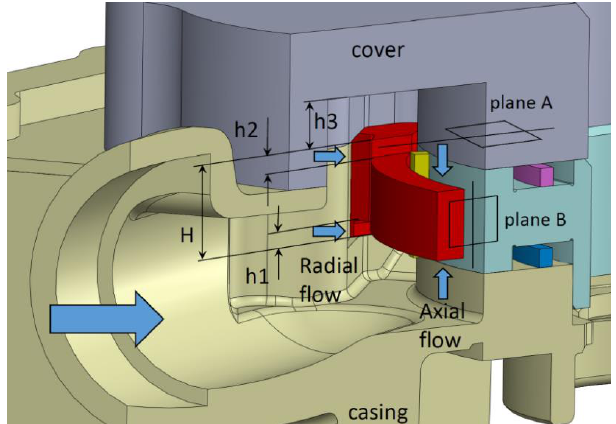
Figure 2. Cross-section of the inlet volume with the indication of the geometric parameters. Planes